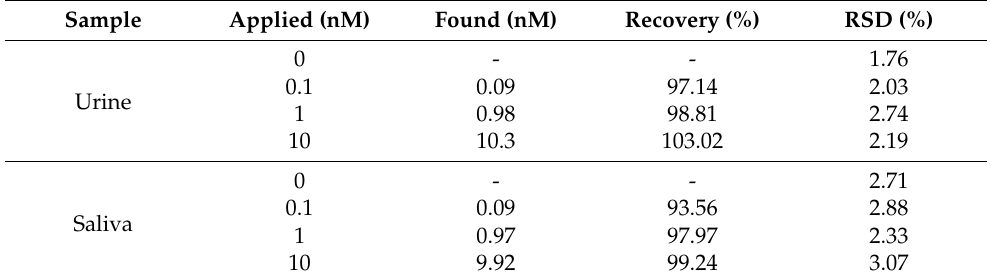
Table 3. Comparison of Hg 2+ determination in human urine samples and artificial